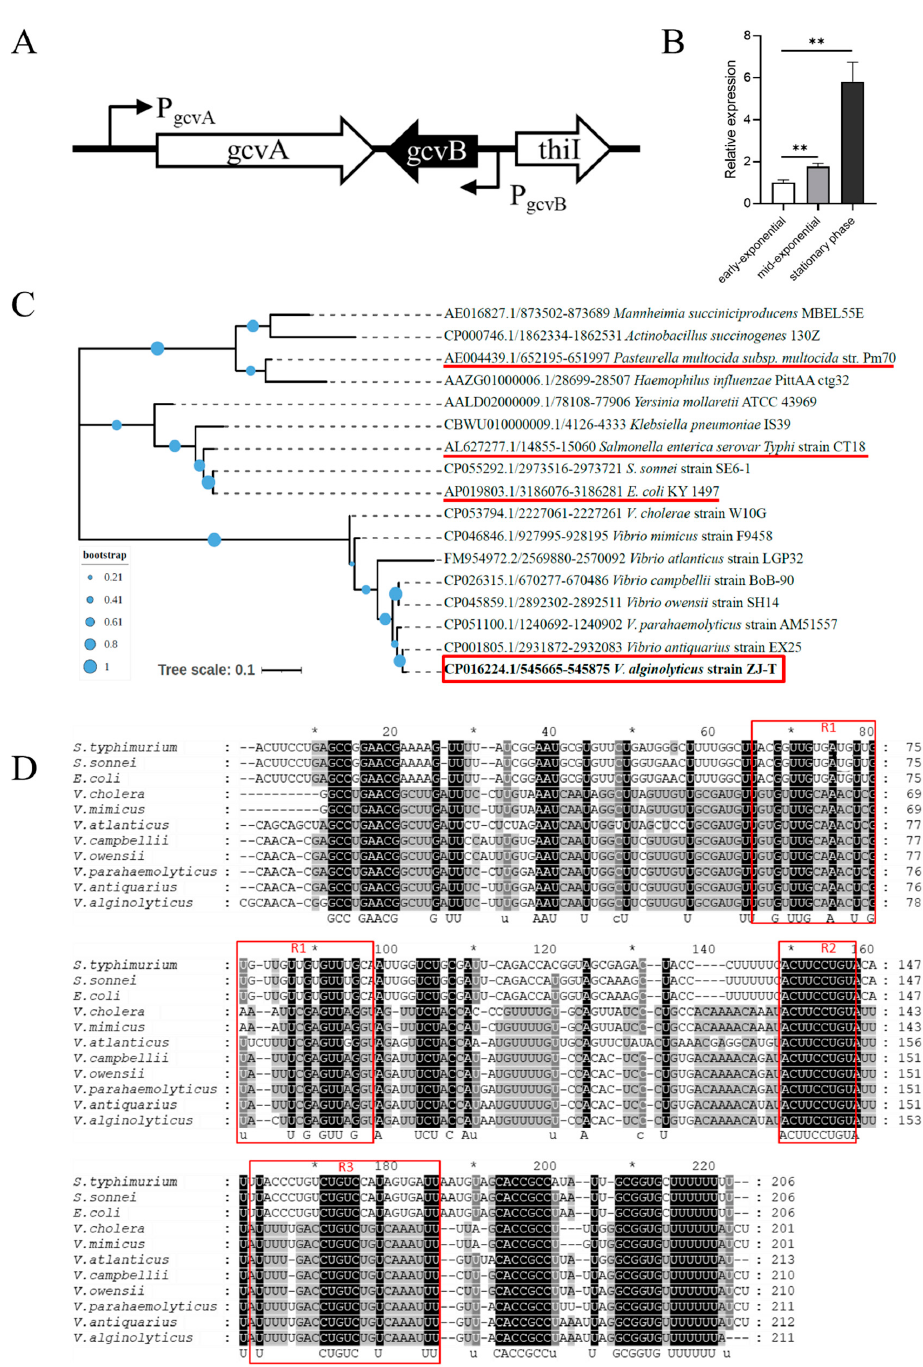
Figure 1. Bioinformatic analysis of gcvB sequence of V. alginolyticus and its expression in LBS. ( A ) Schematic diagram of small RNA GcvB encoding locations. P gcvA and P gcvB indicate gene gcvA and gcvB promoter, and arrows indicate transcription direction and coding direction; ( B ) phylogenetic analysis of gcvB among various species using the Maximum likelihood-method with a bootstrap value of 300; ( C ) conservation analysis of GcvB sequences among various species; ( D ) relative expression of GcvB in different phase (Student ’s t -test, p value: *, <0.05, **, <0.01). The levels of gcvB were normalized to the internal control 16S rRNA level. Error bars indicate standard